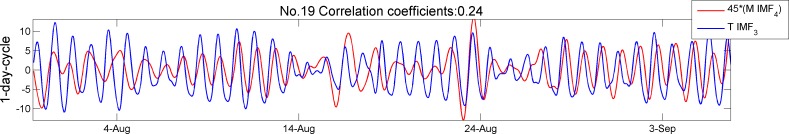
Enlarged view of 1-day cycle